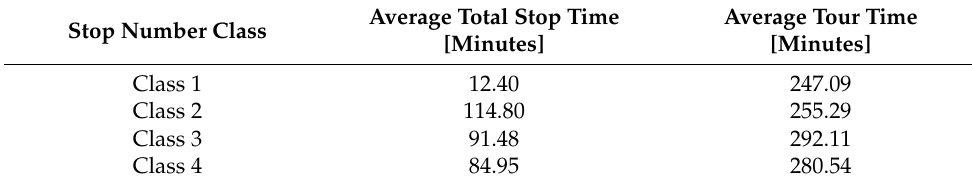
Table 4. Average parking and delivering